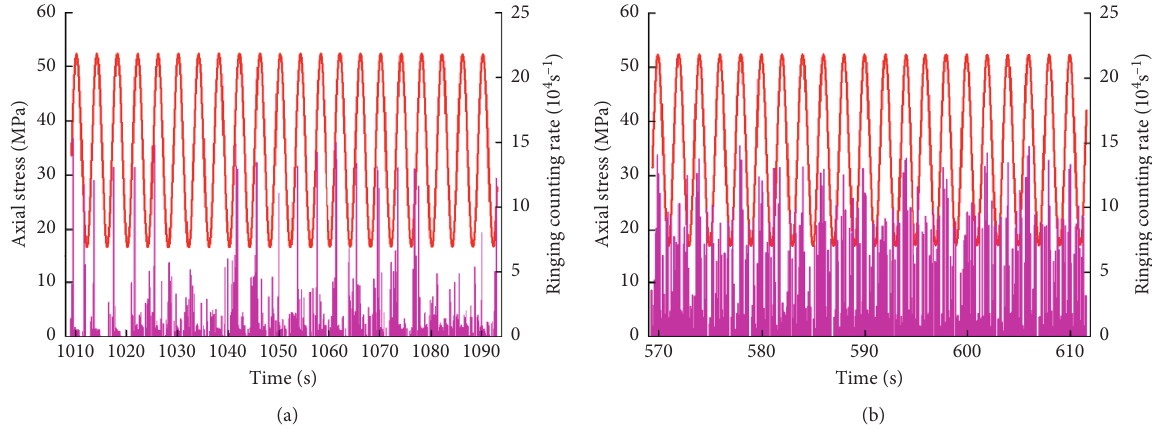
Figure 8: Acoustic emission ringing counting rate under the same confining pressure and stress level and different cyclic loading frequency. (a) MB-3, 0.25 Hz and (b) MB-4, 0.5 Hz.